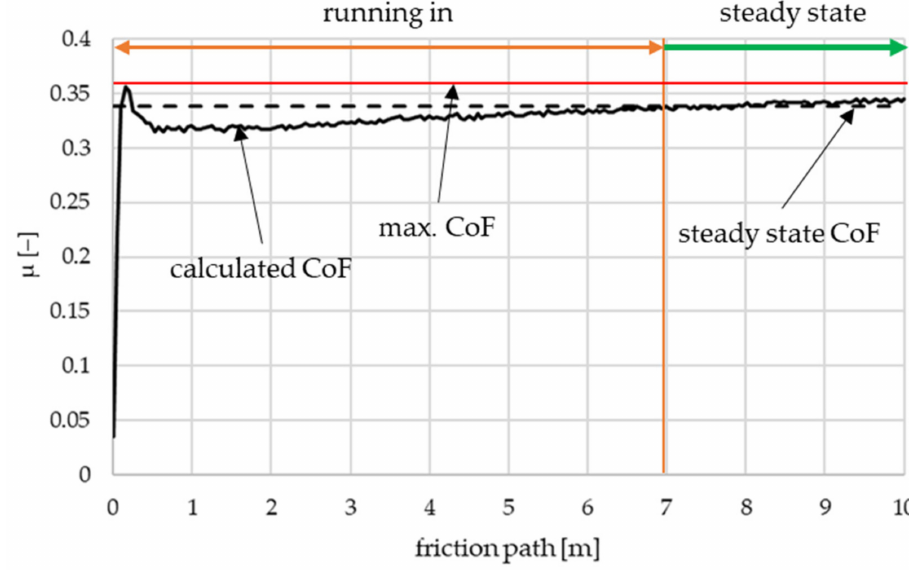
Figure 7. Example of coefficient of friction graph. Two parameters were determined for each specimen’s pv -level measurement: the maximum CoF and the steady state CoF. From each measurement, the former is the highest coefficient of friction during the running-in phase, the latter is the mode of all the coefficient of friction values calculated. Steady state friction phase is considered from the point when the difference between calculated steady state and measured coefficient of friction values is lower than